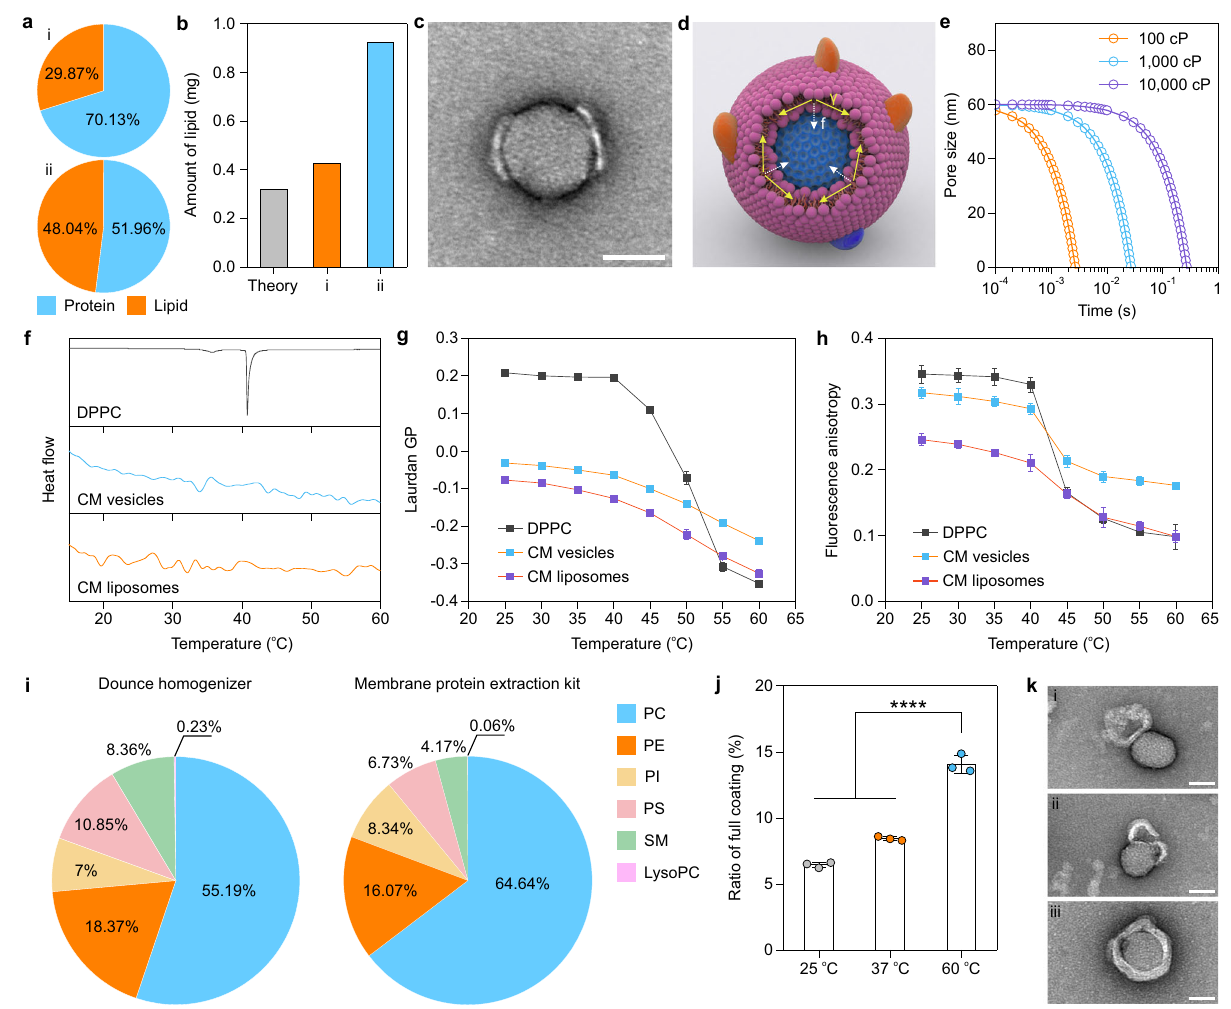
Fig. 3 | Fixing of partial CM coating. a Pie charts representing the weight per- centage of membrane proteins and membrane-associated phospholipids in the collected CMs, where CM isolated by Dounce homogenizer (i) and membrane proteinextractionkit(ii)werecompared. b Comparisonoftheamountoflipidused forcoatingwiththetheoreticalcalculationofrequiredlipidamountforfullcoating of NPs (1mg) and experimental condition (i: Dounce homogenizer; ii: membrane protein extraction kit). c A typical TEM image of partially coated CM-SiO 2 NPs showing the two CM patches that need to be further fused. Scale bar, 50nm. d Schematicillustrationofthe fi xingofpartialCMcoatingdrivenbythelinetension ( ϒ ). f: fi xing force. e Pore size as a function of time and membrane viscosity (100, 1000 and 10,000cP) under the constraint of membrane tension. f Differential scanning calorimetry (DSC) curves of DPPC liposomes, CM vesicles, and CM lipo- somes. g , h Temperature dependence of laurdan generalized polarization (GP; g ) and fl uorescence anisotropy ( h ) values in DPPC liposomes, CM vesicles, and CM